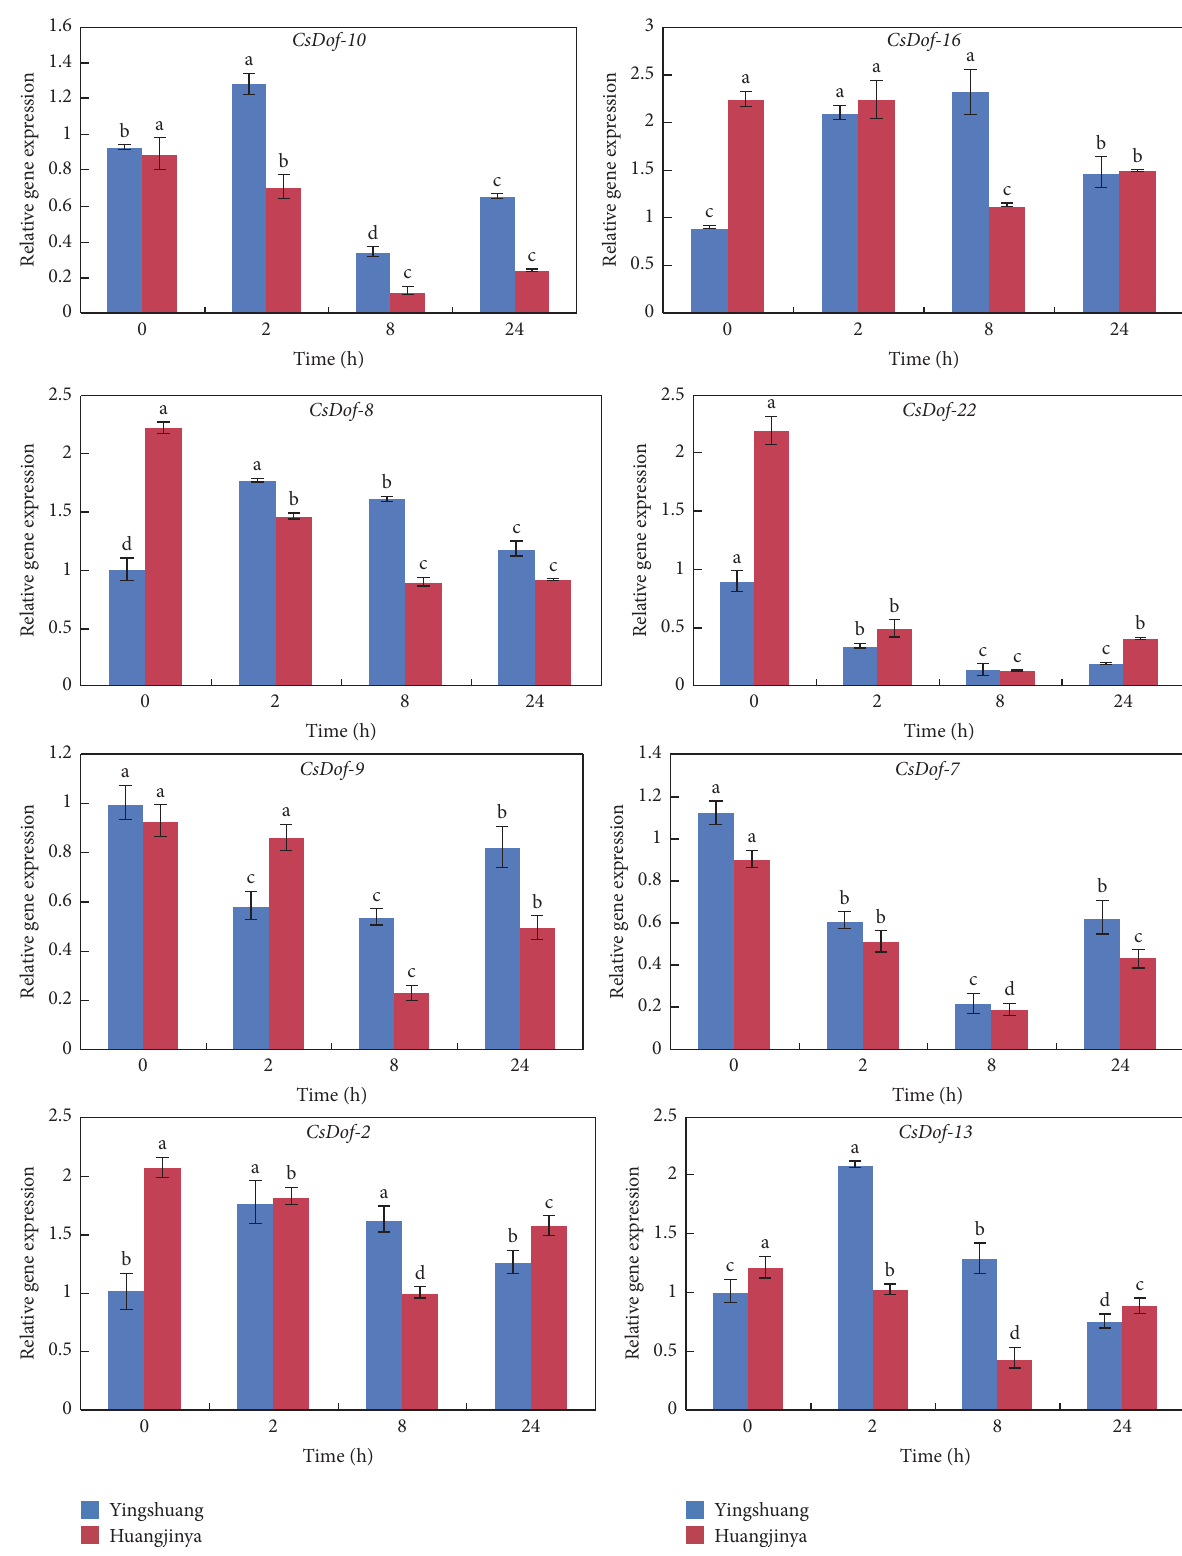
Figure 11: Expression patterns of CsDof genes in “Yingshuang” and “Huangjinya” under drought stress. Error bars represent standard deviation among three real-time quantitative PCR reaction replicates. Data are means of three technical replicates ± SD. Different lowercase letters indicate significant differences at 𝑃 < 0.05